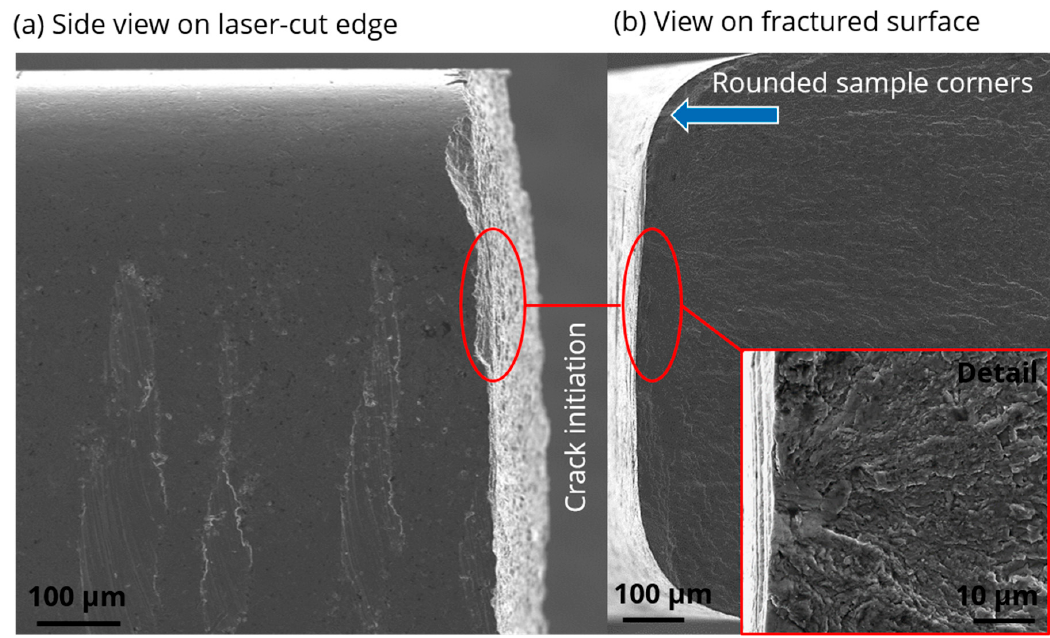
Figure 8. Fractography of a Ti-6Al_BG sample with barrel-grinded surface condition failed at 375 MPa and 5.1 × 10 4 cycles: ( a ) SEM (SE) analysis of the laser-cut edge with detectable notches; ( b ) The corresponding fracture surface with detailed view on fatigue crack initiation.